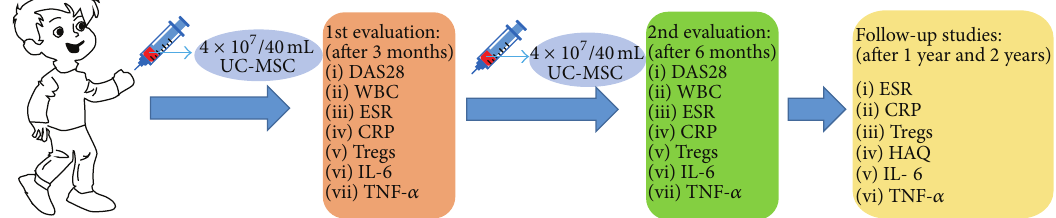
Figure 1: UC-MSC treatment and evaluation procedure. All the 10 patients received infusion with 4 × 10 7 /40 mL MSCs. After 3 months, DAS28 value was measured and peripheral blood of each patient was obtained for WBC, ESR, CRP, Tregs, IL-6, and TNF- 𝛼 measurement. The patients were given the second cell infusion later, and the second measurement was done three months later. Follow-up studies were carried out for 1 year and 2